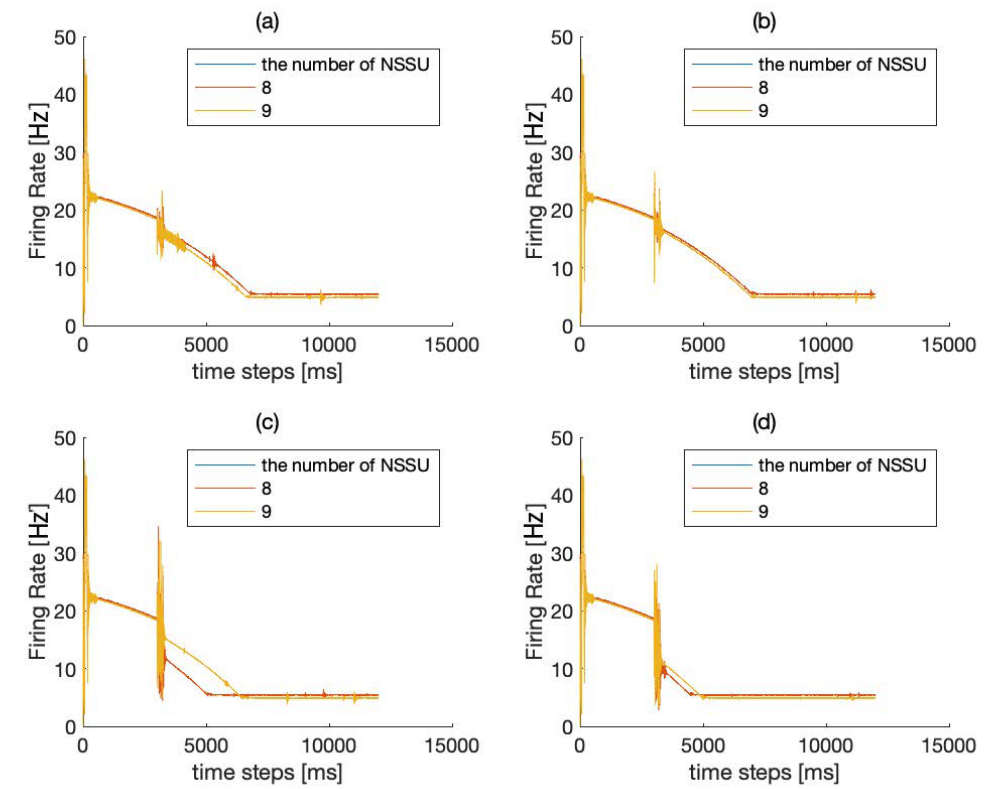
Figure 4. ( a ) Firing rate of 8–9 NSSUs when adding a maximum intensity of 5% J EE disturbance within a time range of 2%. ( b ) Firing rate of 8–9 NSSUs when adding a maximum intensity of 5% J IE disturbance within a time range of 2%. ( c ) Firing rate of 8–9 NSSUs when adding a maximum intensity of 5% J EI disturbance within a time range of 2%. ( d ) Firing rate of 8–9 NSSUs when adding a maximum intensity of 5% J II disturbance within a time range of 2%. The robustness of 8 NSSUs and 9 NSSUs is basically the same, but the computational complexity of 9 NSSUs is higher. This figure demonstrates that 8 NSSUs are the most suitable for this